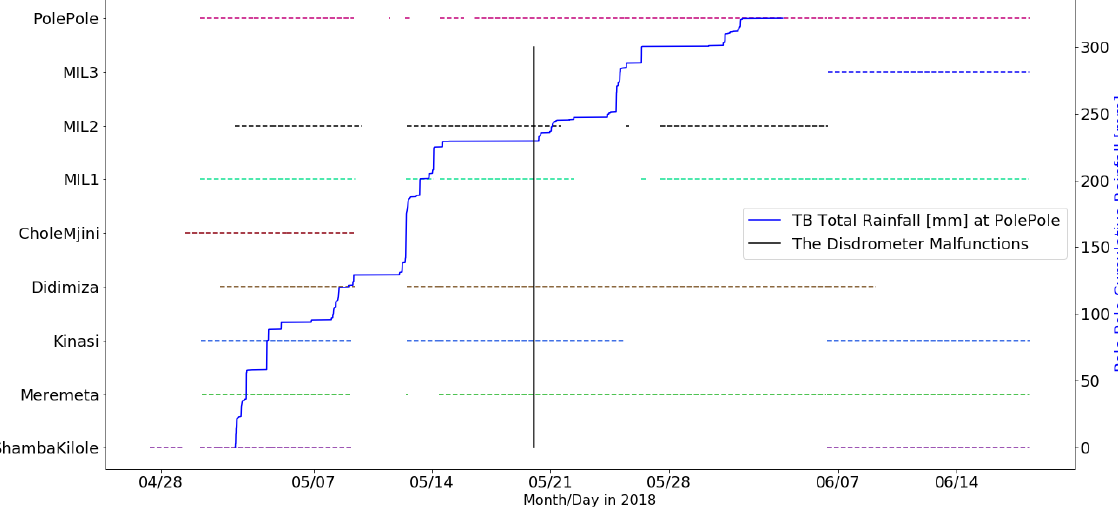
Figure 2. Record of the time periods during which the intervalometers collected data for each intervalometer site and the total rainfall amount [mm] from the tipping bucket at Pole